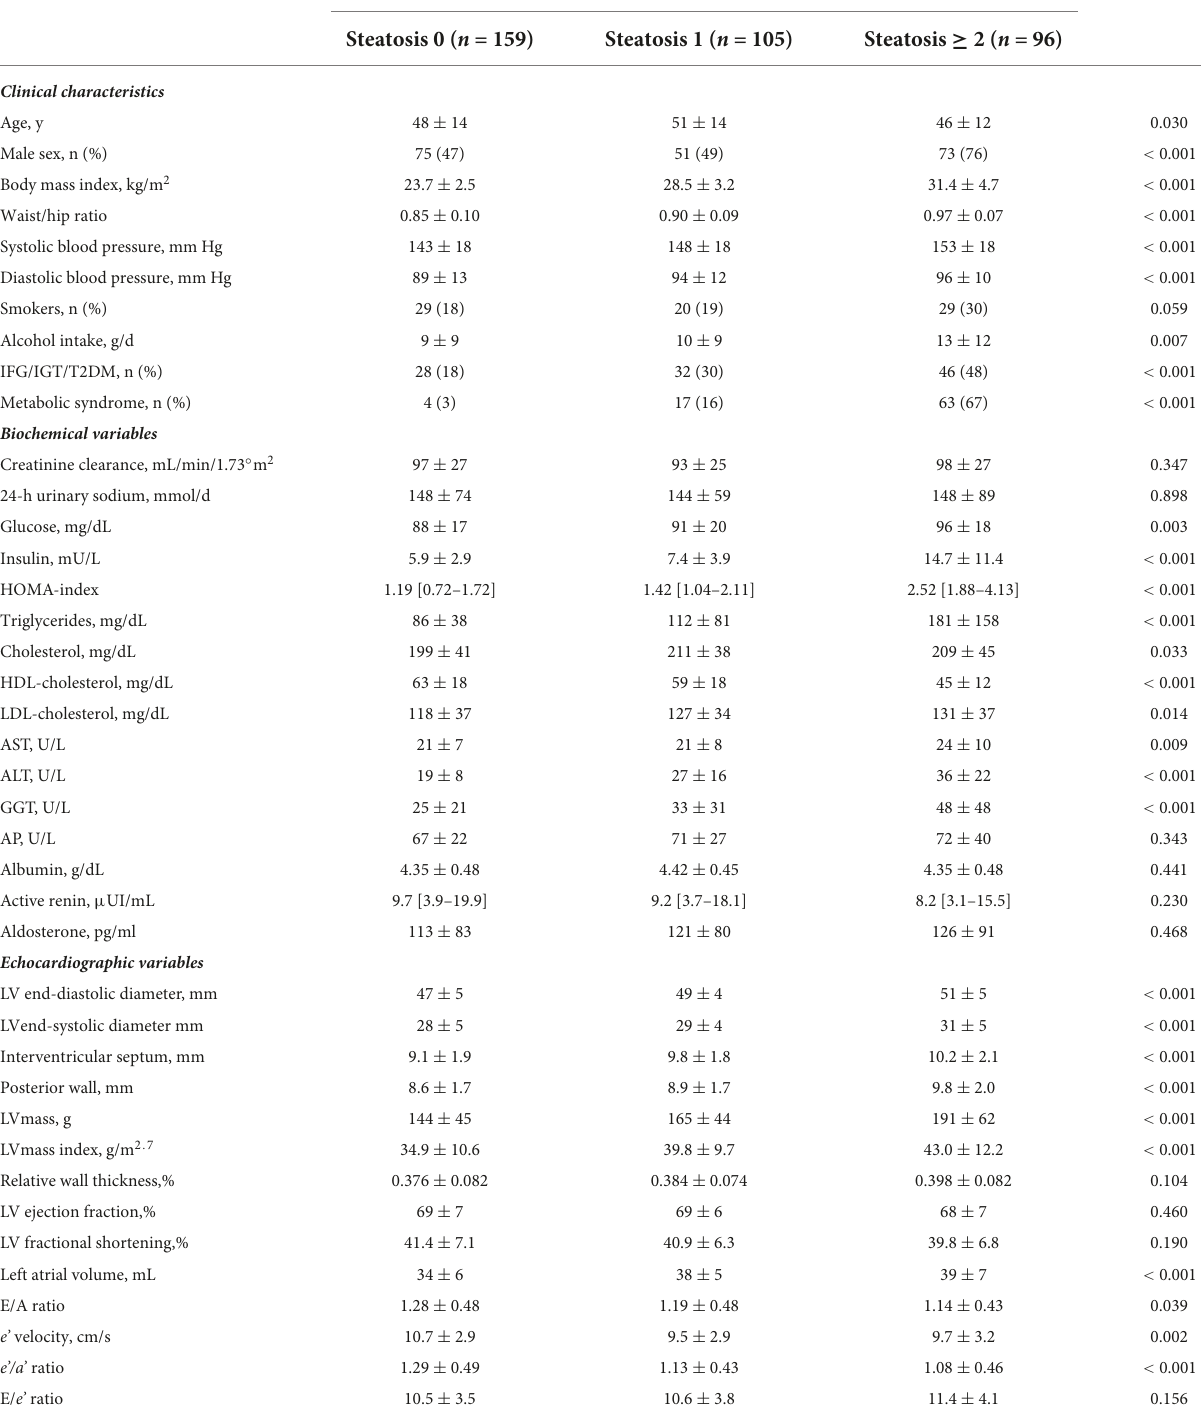
TABLE 3 Clinical characteristics and biochemical and echocardiographic variables of hypertensive patients who were grouped according to absence, or presence (1 or ≥ 2) of positive liver steatosis scores.